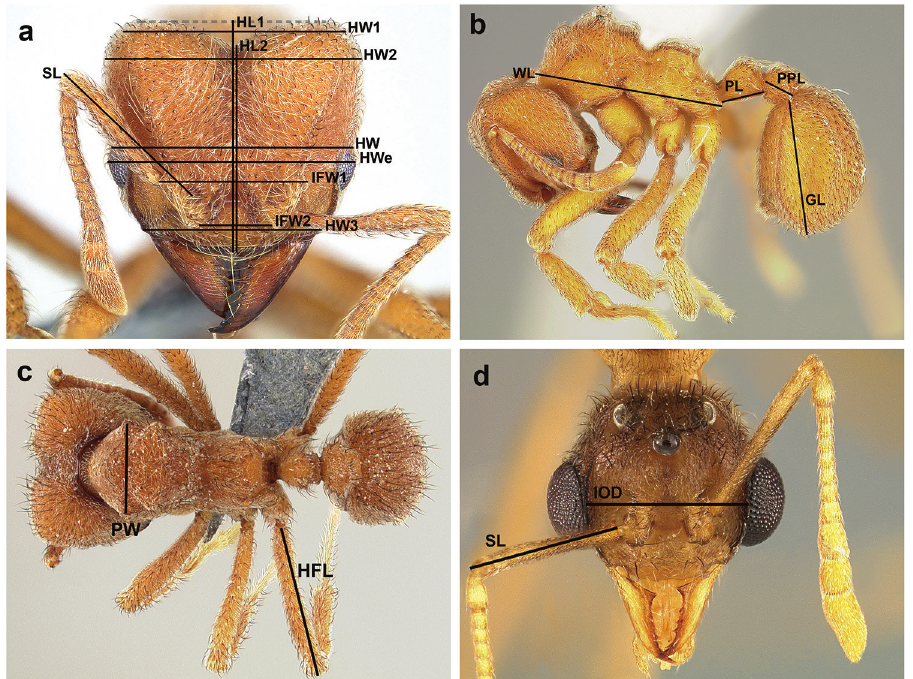
Figure 2. Morphological measurements. Indicating measurements of the worker ( a, b, c ) and male ( d ). HWe Head width including the eyes HW head width just above the eyes HW1 head width at the top of the head HW2 posterior head width HW3 anterior head width HL1 head length 1 HL2 head length 2 SL scape length IFW1 interfrontal width 1 IFW2 interfrontal width 2 WL Weber’s length PL petiole length PPL postpetiole length GL gaster length PW pronotal width HFL hind femur length IOD interocular IFW2 Interfrontal width 2: in full face-view, the maximum distance between the interior margins of the frontal lobes, or the distance between the points where the lateral and medial margin of each frontal lobe meet. IOD Interocular distance (male only): in full-face view, the maximum width of the head measured at the midpoint of the internal margin of the eyes (Figure 2d). Om Ommatidia count: in lateral view, number of ommatidia visible in the maxi- mum diameter of the eye. WL Weber’s length: in lateral view, length of the mesosoma from the point where the pronotum curves into the cervical shield to the posteriormost ven- tral angle of the propodeum. HFL Hind femur length: in most appropriate view (usually the dorsal), length of the hind femur, not including the trochanter. PL Petiole length: in lateral view, the maximum length of the petiole measured from the posteriormost margin of the metapleural gland lobe to the posteri- ormost margin of the petiole.